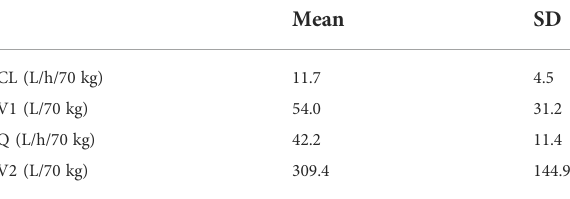
TABLE 3 Everolimus pharmacokinetic parameter